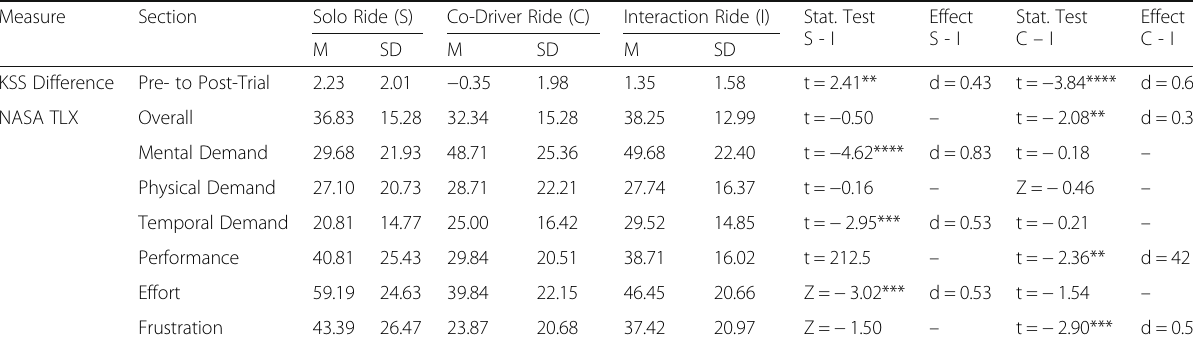
Table 3 Results related to the subjective experience